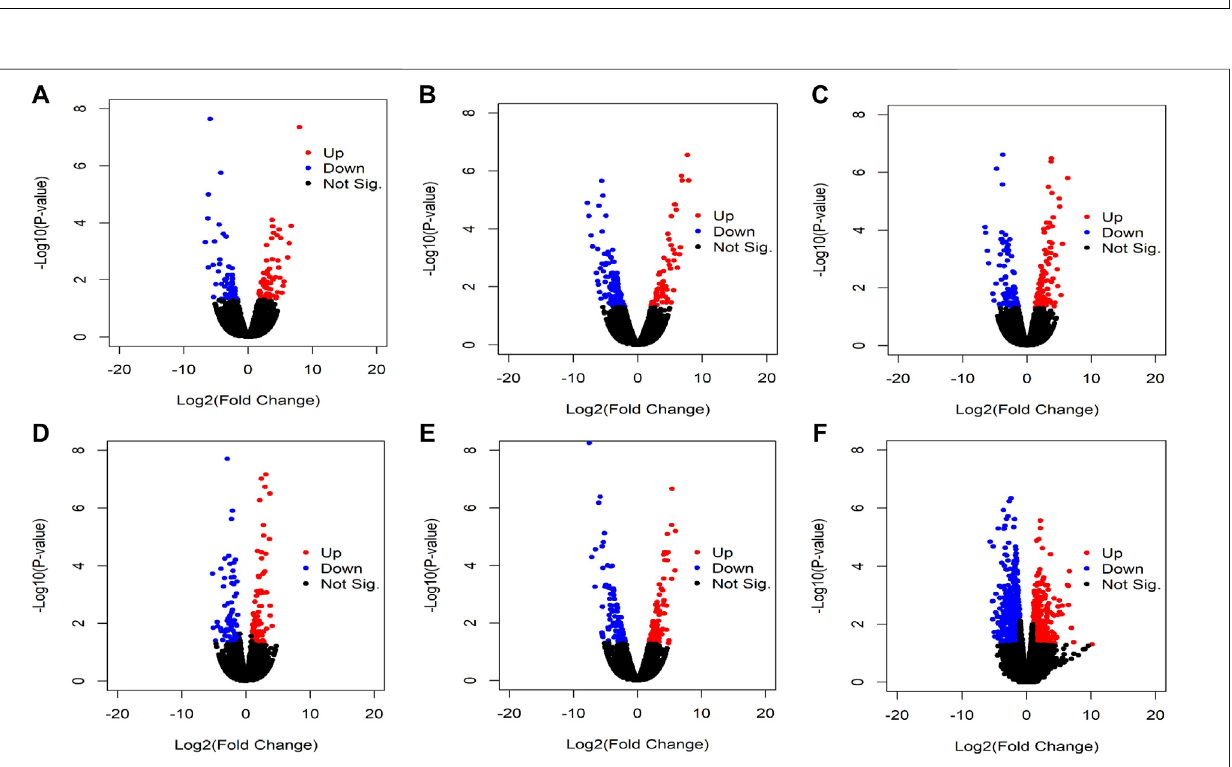
FIGURE 3 | Volcano plot of the circRNAs. Red colors indicate upregulated circRNAs while blue colors indicate downregulated circRNAs and black colors indicate not signi fi cant. Results of DE analysis of (A) Sample_1N vs Sample_1T, (B) Sample_2N vs Sample_2T, (C) Sample_3N vs Sample_3T, (D) Sample_4N vs Sample_4T, (E) Sample_5N vs Sample_5T, and (F) Sample_N vs Sample_T.